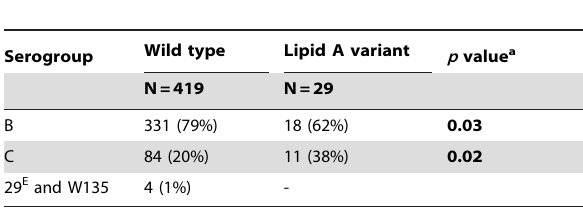
Table 1. Serogroup distribution of lipid A variants among isolates from patients with invasive meningococcal disease.